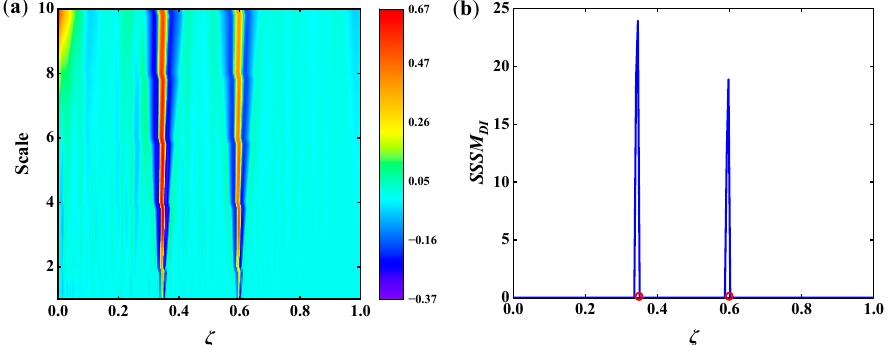
Figure 22. Damage identification results of scenario I under impulsive load when γ = 10%: ( a ) CS ( b, s ) ; ( b ) Damage index SSSM DI